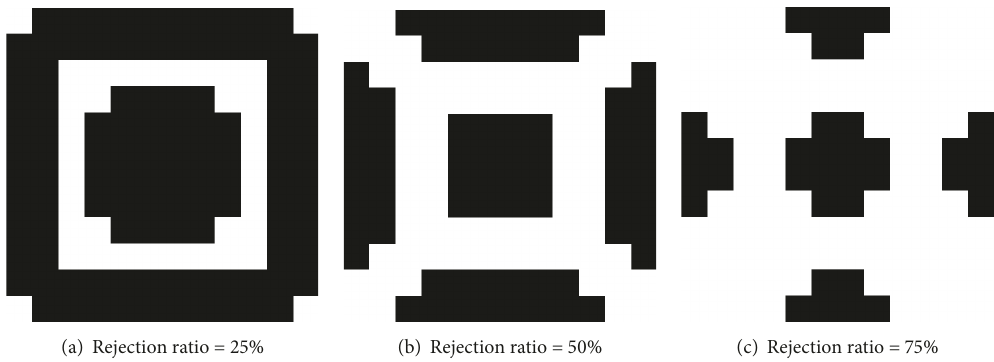
Figure 7: Optimal CLD layouts obtained using ESO under various rejection ratios for first